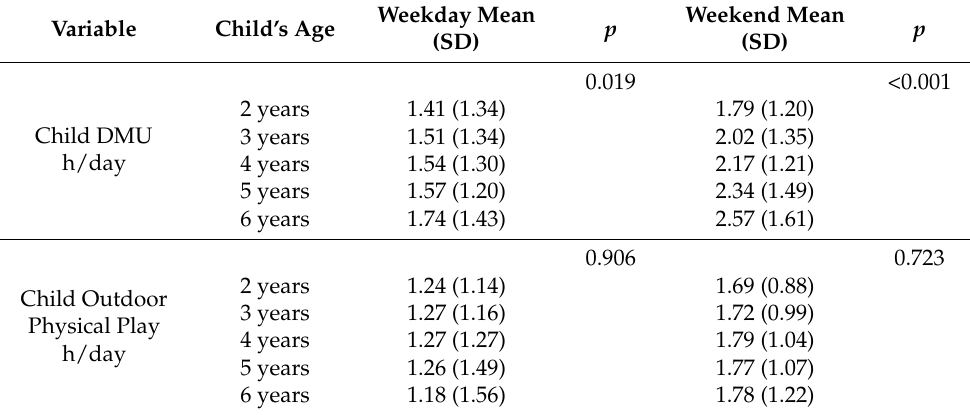
Table 2. Children’s digital media use (DMU) and outdoor physical play by child’s age.